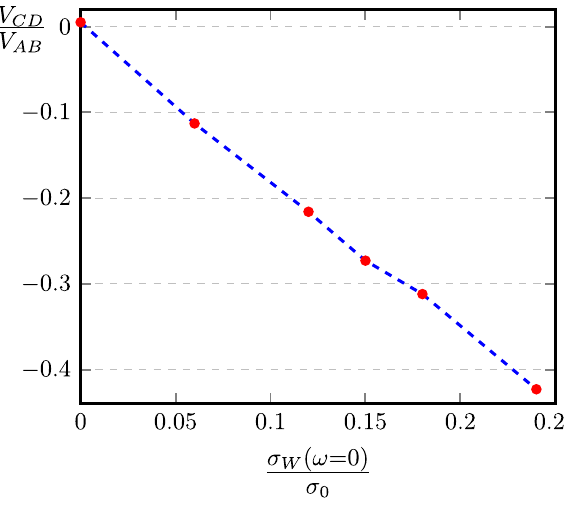
FIG. 7. The ratio of the voltages on the bottom and top surfaces as a function of the ratio σ W = σ 0 . The voltage ratio is calculated numerically, in the limit σ W = σ 0 ≪ 1 , using the approximated Eqs. (A1) – (A3). In the limit σ W ≫ σ 0 , the voltage ratio tends to